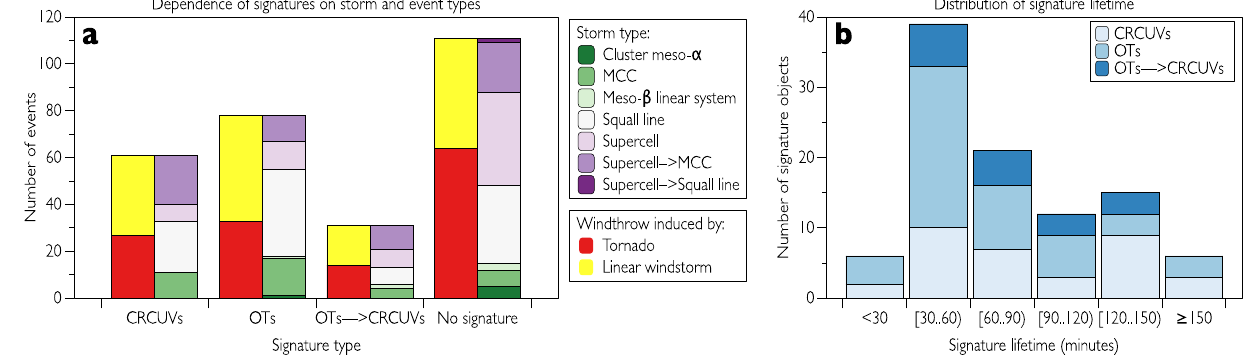
Figure 6. ( a ) Number of the tornado and straight-line winds events formed within a storm of different types associated with various signatures on storm cloud tops, ( b ) distribution of the signatures depending on their lifetime.